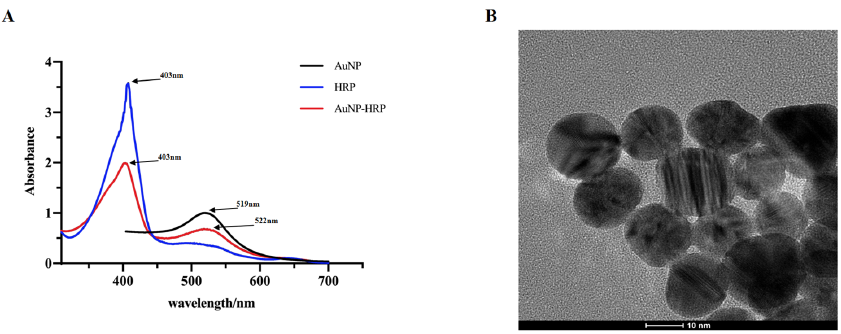
Figure 2. ( A ) UV-Vis Spectroscopic scanning characterization of GNPs and the e ff ect of GNPs ad- sorption of HRP; ( B ) TEM representation images of the con fi gured GNPs.